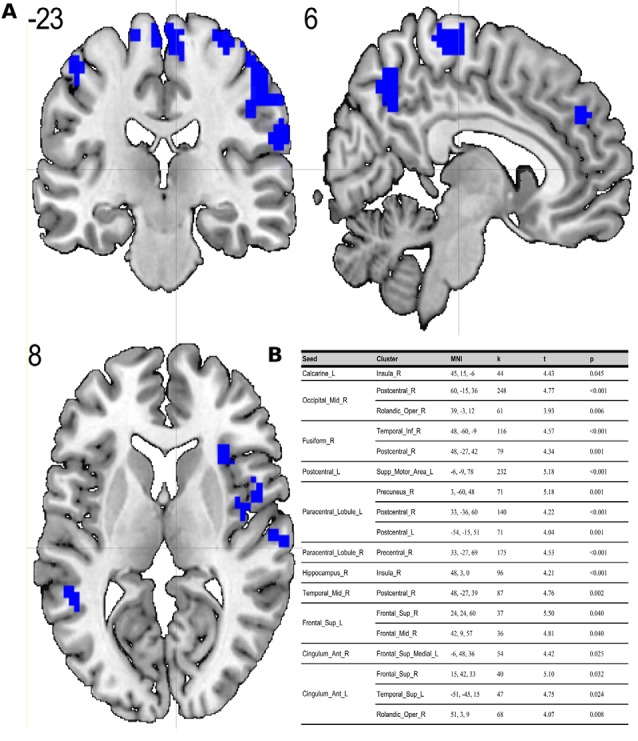
(A) Results of two-sample t-test on functional connectivity maps with ES > MS contrast. Blue areas depict increased functional connectivity in the evening session compared to the morning session (p < 0.05; FDR corrected on cluster level). (B) Table representing seeds with the presence of at least one positively correlated cluster with significant (p < 0.05; FDR corrected on cluster level) differences between evening and morning sessions.